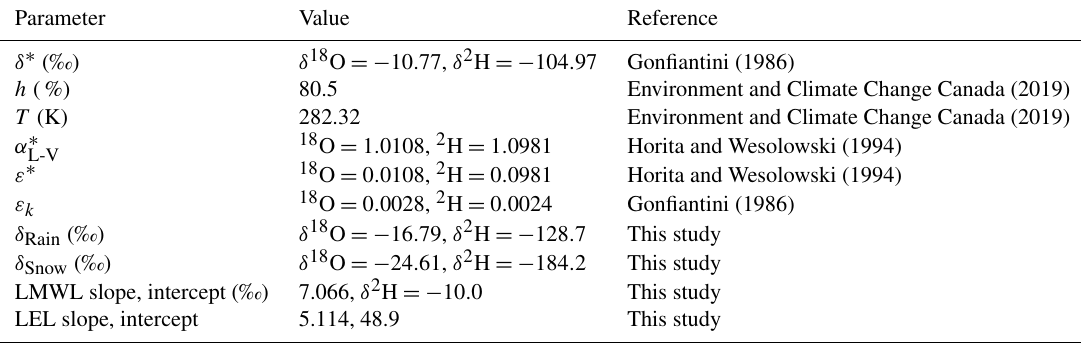
Table B1. Variables used in the isotope framework and sources of their calculation.